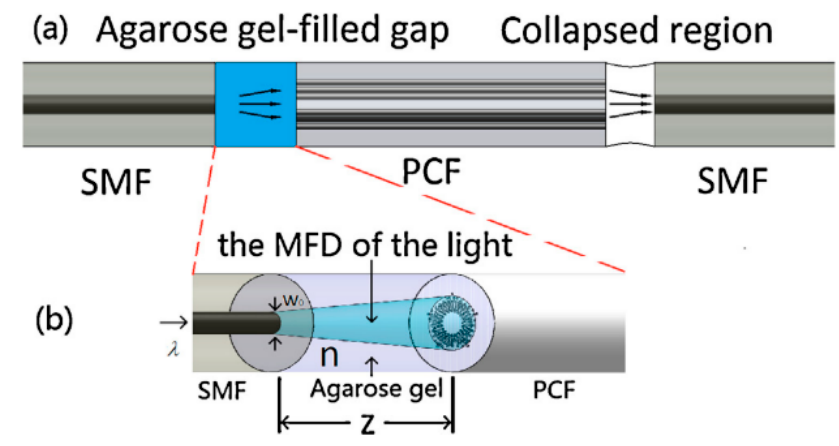
Figure 15. ( a ) Schematic diagram of the PCF based humidity sensor and; ( b ) the Mode Field Diameter Figure 15. (a) Schematic diagram of the PCF based humidity sensor and; (b) the Mode Field Diameter (MFD) of the light in the Agarose gel. Reprinted with permission from (MFD) of the light in the Agarose gel. Reprinted with permission from [101].